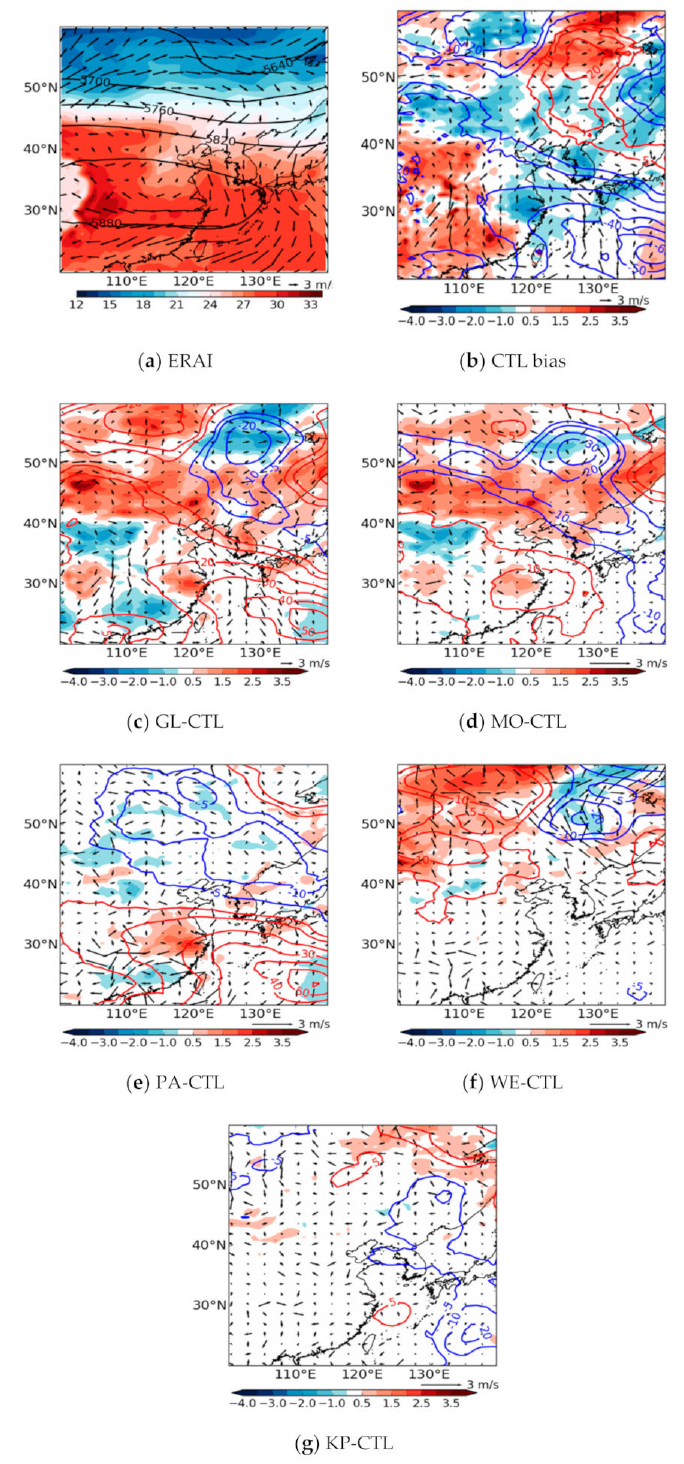
Figure 5. ( a ) 500 hpa geopotential height (contour), 1000 hPa temperature ( ◦ C, shaded) and 850 hPa wind (vector) of ERA Interim reanalysis (ERAI), ( b ) 7-day forecasted 500 hPa geopotential height (contour, blue and red line represent positive and negative bias, respectively), biases for the 7-day forecasted 850 hPa wind (vector) and 1000 hPa temperature (shaded) in the CTL experiment. ( c – g ) Di ff erences of 7-day forecasted 500 hPa geopotential height (contour), 850 hPa wind (vector) and 1000 hPa temperature (shaded) between each experiment and the CTL experiment. Biases are calculated with the MetUM analysis. All values are averaged during the heat wave period (11–25 August